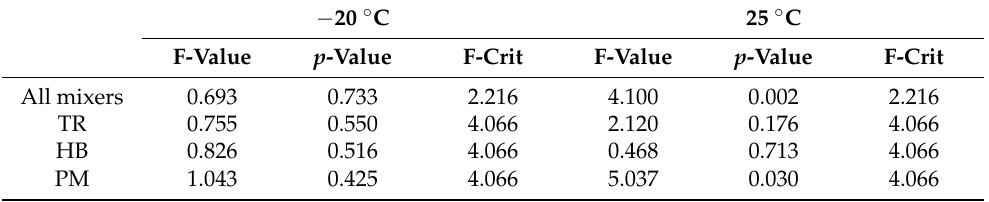
Table 10. One-way ANOVA of IDT results at − 20 and 25 ◦ C (significance level = 0.05). − 20 ◦ C 25 ◦ C F-Value p -Value F-Crit F-Value p -Value F-Crit All mixers